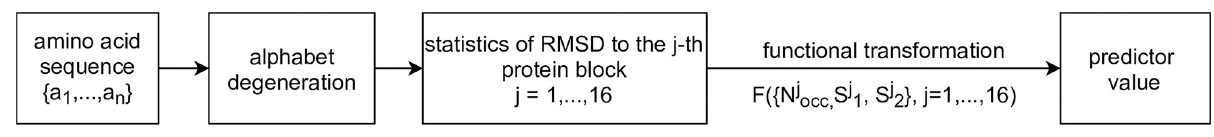
Fig 3. Generation of predictors based on RMSD statistics between a protein fragment and the 16 basic protein blocks, schematic representation.